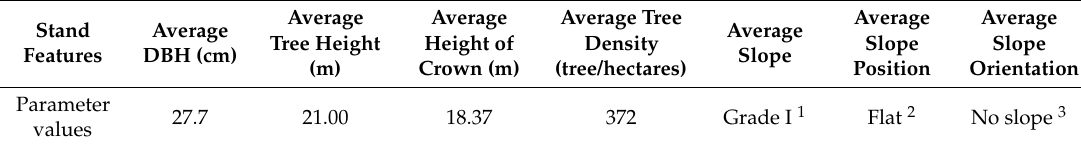
Table 1. Feature parameters of sample